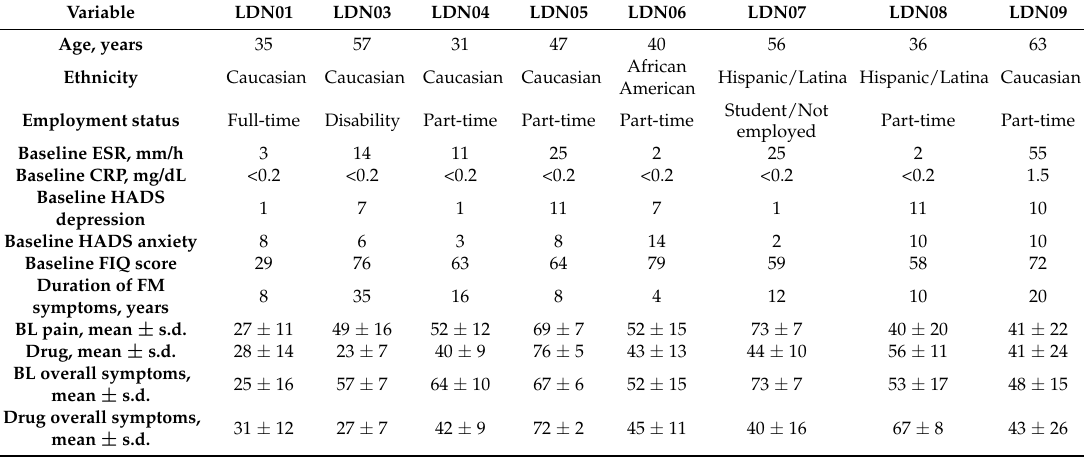
Table 1. Individual participant demographic and clinical data for baseline (screening) and key study periods. Including erythrocyte sedimentation rate (ESR), c-reactive protein (CRP), hospital anxiety and depression scale (HADS), and fibromyalgia impact questionnaire (FIQ). LDN01 LDN03